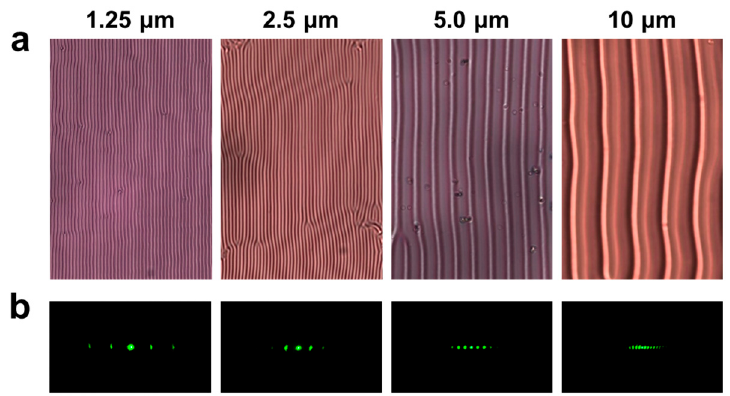
Figure 2. ( a ) POM images and ( b ) diffraction patterns of the fabricated uniform-lying-helix (ULH) cells (the pitches are set as 1.25, 2.5, 5.0, and 10 μ m). The thickness of LC cells was set as twice the pitch. the